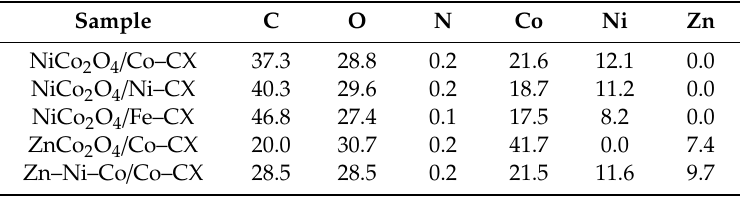
Table 5. Surface chemical composition in wt % obtained by